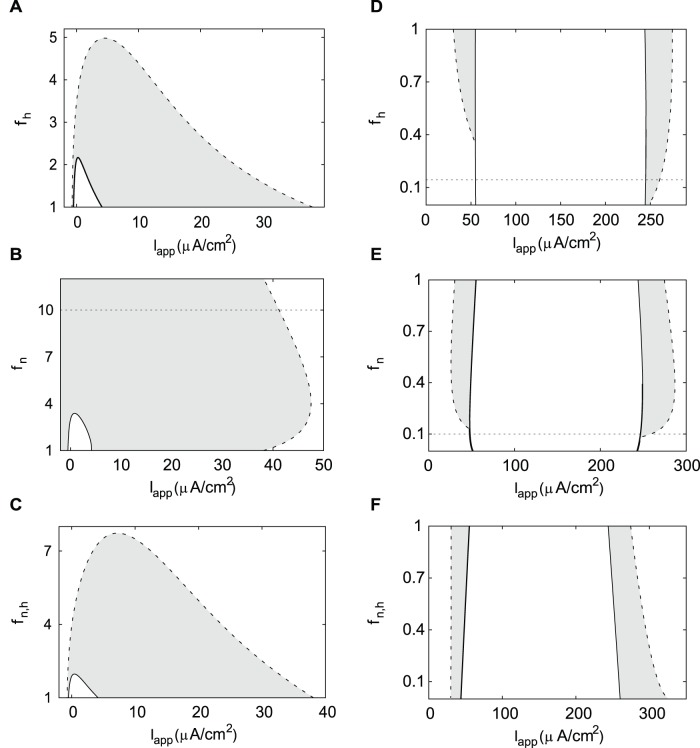
Changing kinetics of gating variables in the DA neuron and the HH neuron.The hysteresis regions are shaded gray. A), B) Bistability range shortens with accelerating the gating variables kinetics in the DA neuron. f
h = 1 and f
n = 1 correspond to parameter set from Figure 4B. C) Simultaneous acceleration of both n and h variables decreases the size of bistability range. f
n,h = 1 corresponds to parameter set from Figure 4B. D), E) Hysteresis is reduced or eliminated in the HH neuron with slowing the individual current kinetics. f
h = 1 and f
n = 1 correspond to parameter set from Figure 4D. F) Hysteresis is increased with simultaneous slowing of gating variables n and h. f
n,h = 1 corresponds to parameter set from Figure 4D. A solid curve represents an Andronov-Hopf bifurcation, a dashed curve – a saddle-node bifurcation of limit cycles. Horizontal dotted lines (where shown) give the values of f
h and f
n for which the maximum value of the corresponding time constant function for the DA (HH) neuron matches the maximum value of the time constant for the HH (DA) neuron.